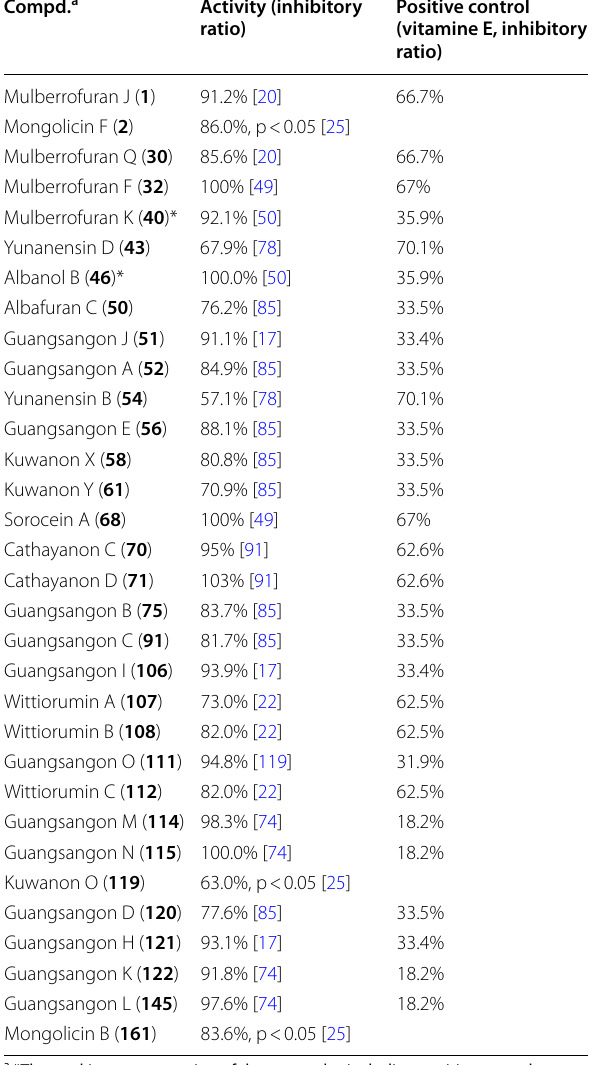
Table 5 Antioxidant activities of MDAAs at concentrations